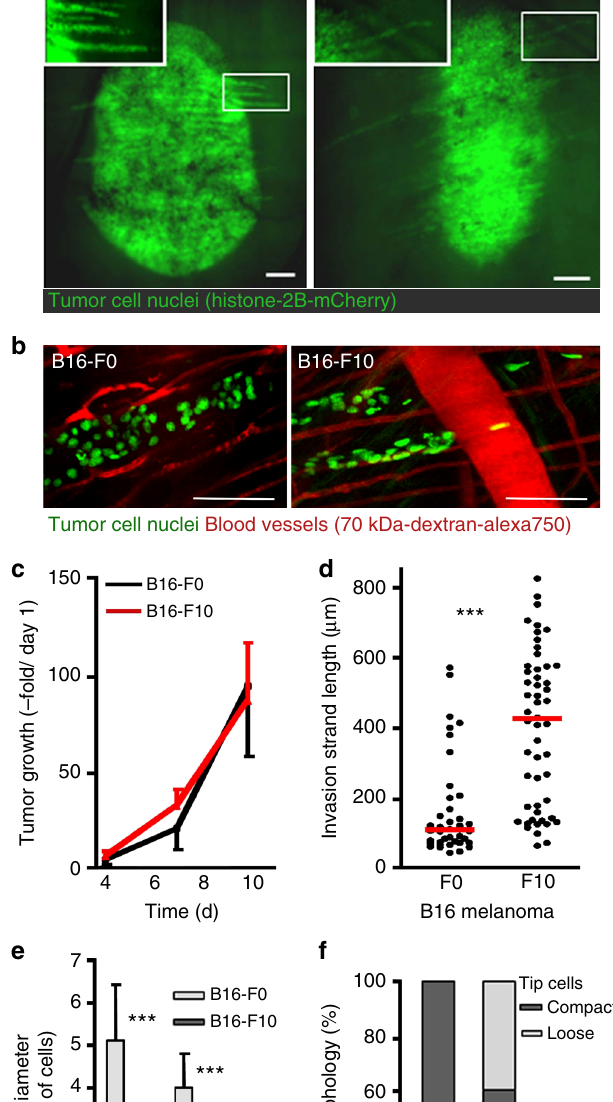
and 2 and Supplementary Methods for all additional details on model fi tting and comparisons). All data sets for metastatic cells pass the goodness-of- fi t test performed according to the method detailed in ref. 56 (Supplementary Note 3 and Supplementary Figure 7). In this context, it is important to note that truncated power law (with µ ~ 1 – 3) has become increasingly favored (over pure power law) as a more relevant model for describing bounded/limited biological systems and — similar to a pure power law — is considered Lévy walk 14,16 – 18 . We also note that (i) “ walks ” rather than “ fl ights ” 15 terminology is appropriate since, as we veri fi ed, our migrating cells exhibit strong correlation between persistence times and persistence lengths (i.e., step sizes);